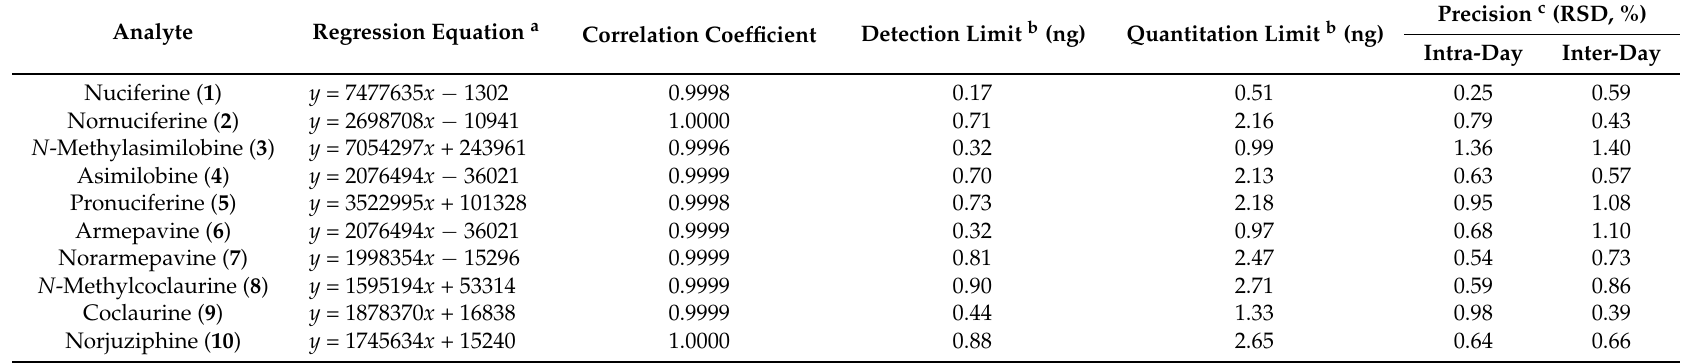
Table 3. Linearities, detection and quantitation limits, and precisions for alkaloids ( 1 – 10 ) in lotus